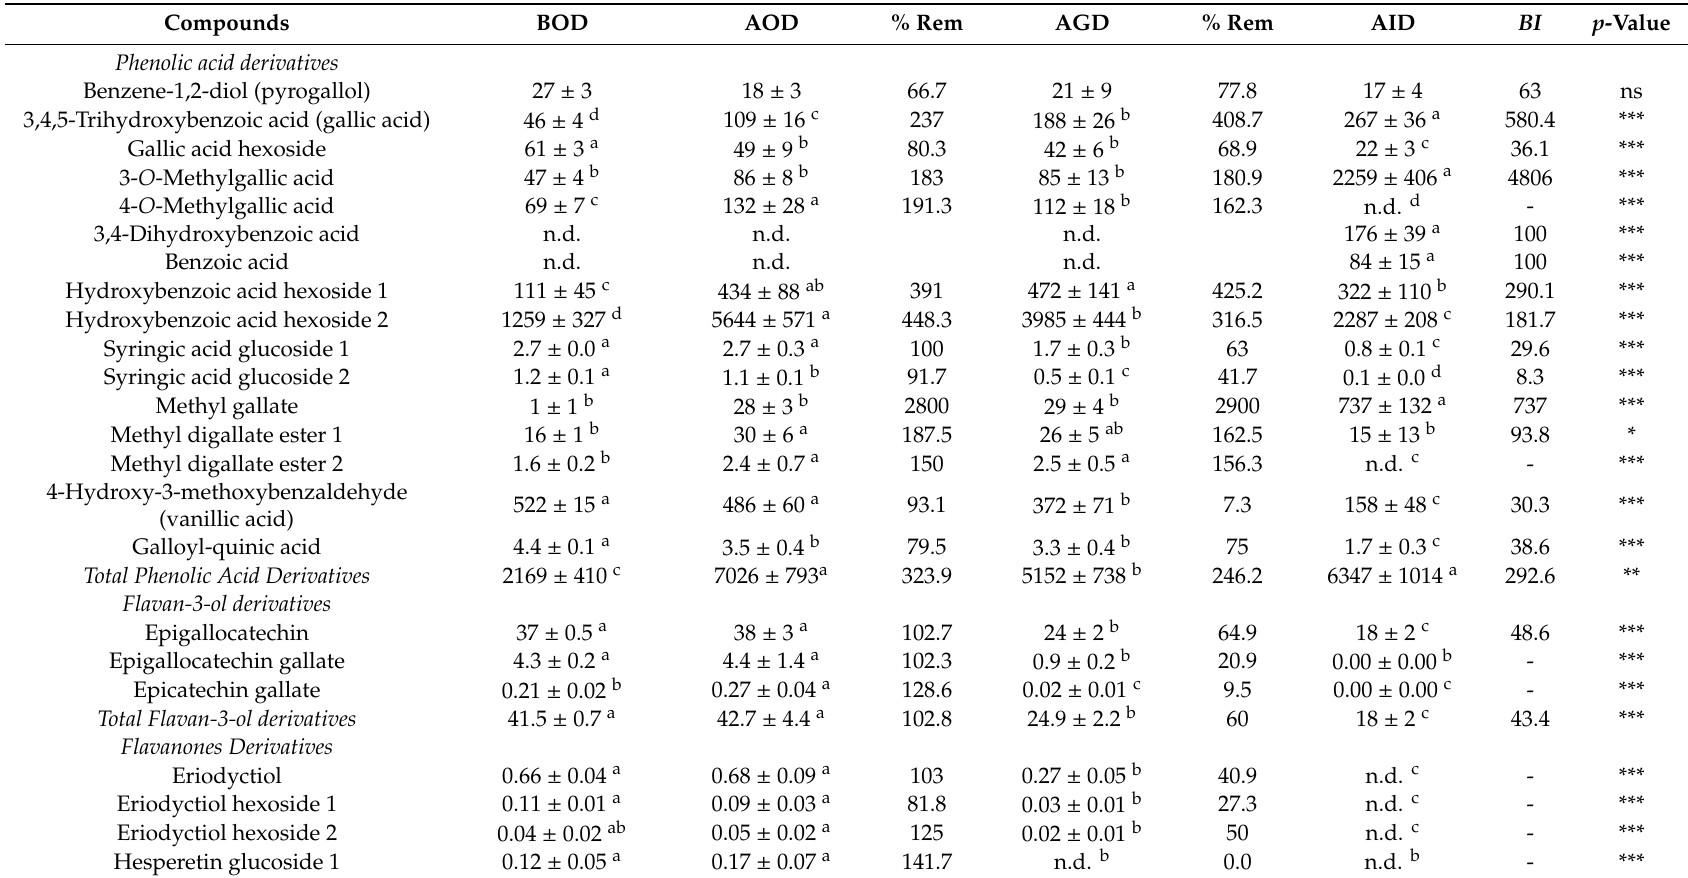
Table 2. Polyphenol compounds in mango puree samples before and after in vitro gastrointestinal digestion. Results are expressed as mean ± standard deviation ( µ mol / g DW) ( n = 3). BOD: before oral digestion; AOD: after oral digestion; AGD: after gastric digestion; AID: after intestinal digestion. % Rem: % remained; BI: Bioaccessibility